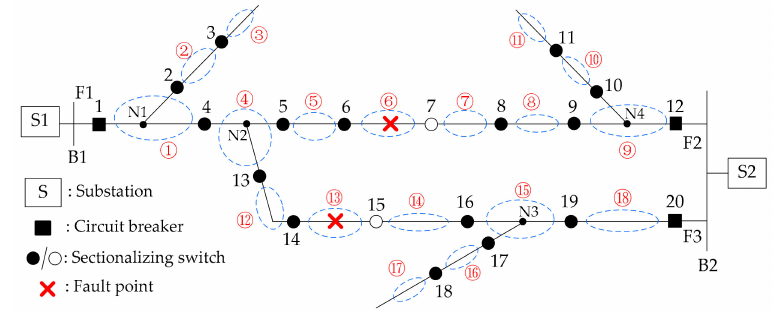
Figure 7. Multiple faults occurring on different branches in the same radial network.